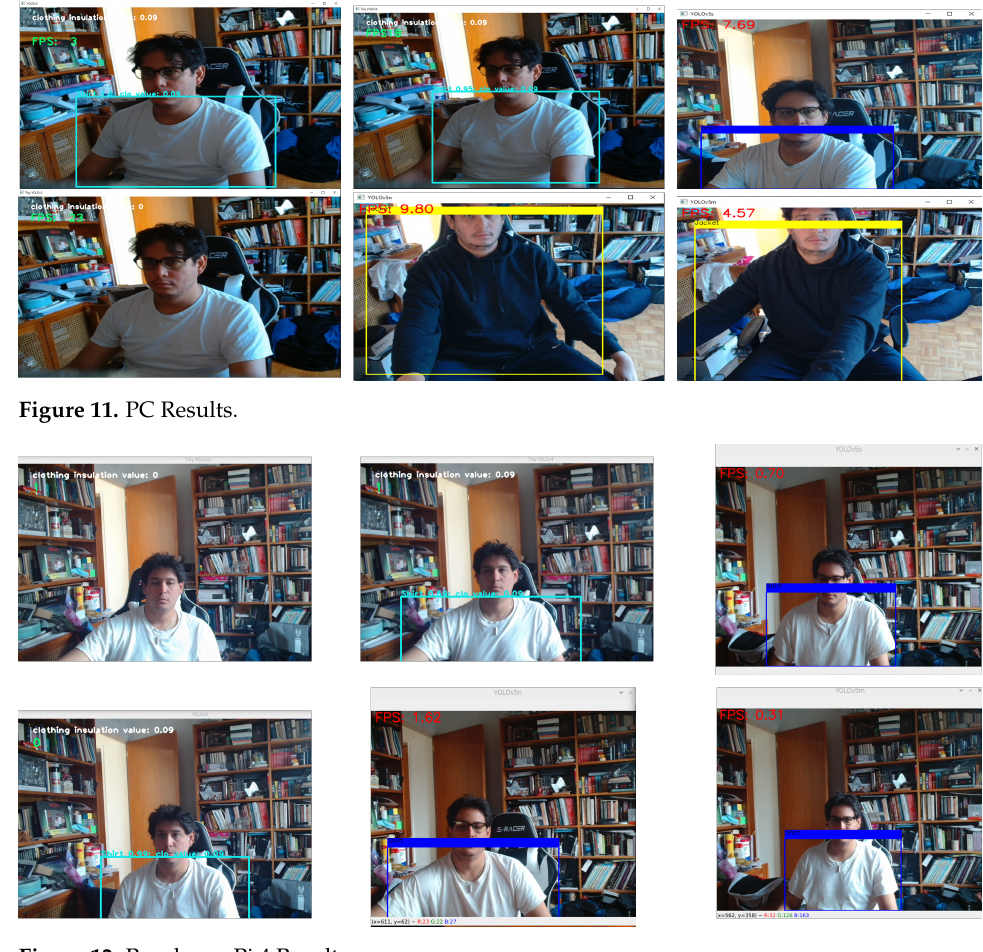
Figure 12. Raspberry Pi 4